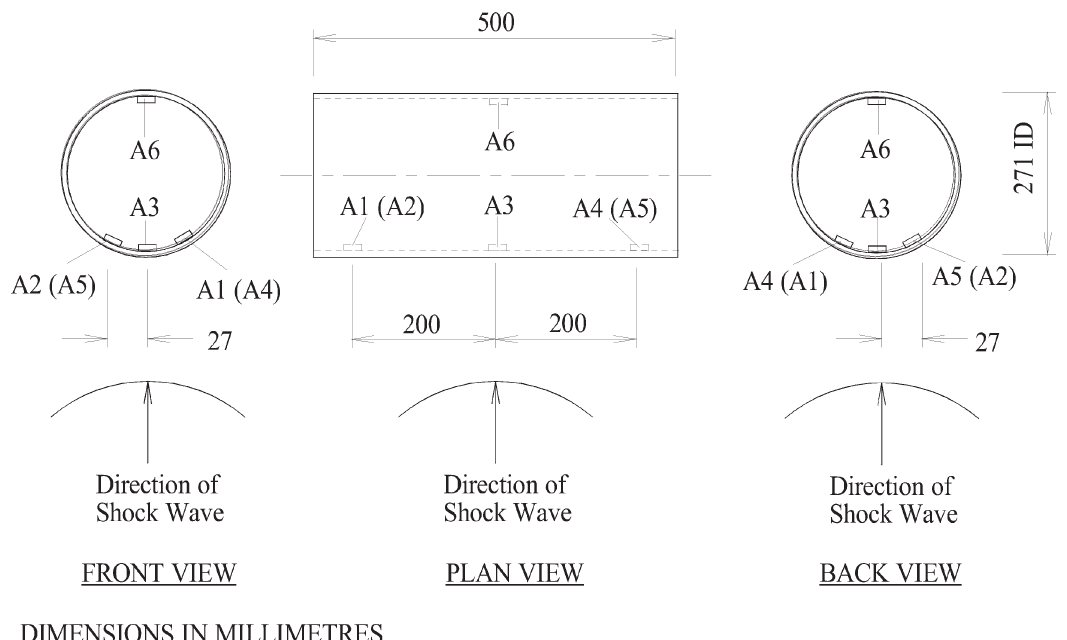
Fig. 7. Detail of accelerometer locations. Accelerometers in parenthesis are hidden from